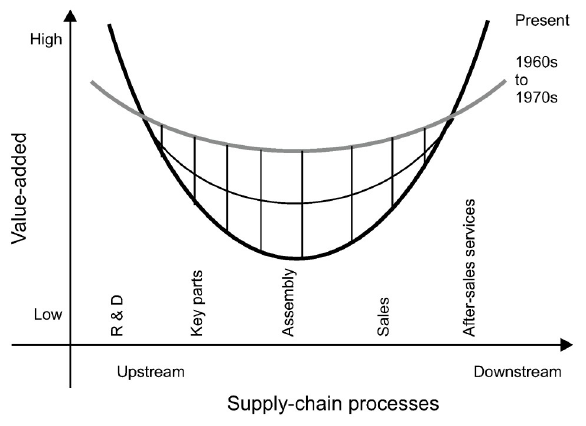
Fig 1. Spatial positioning map for the value chain models of enterprises